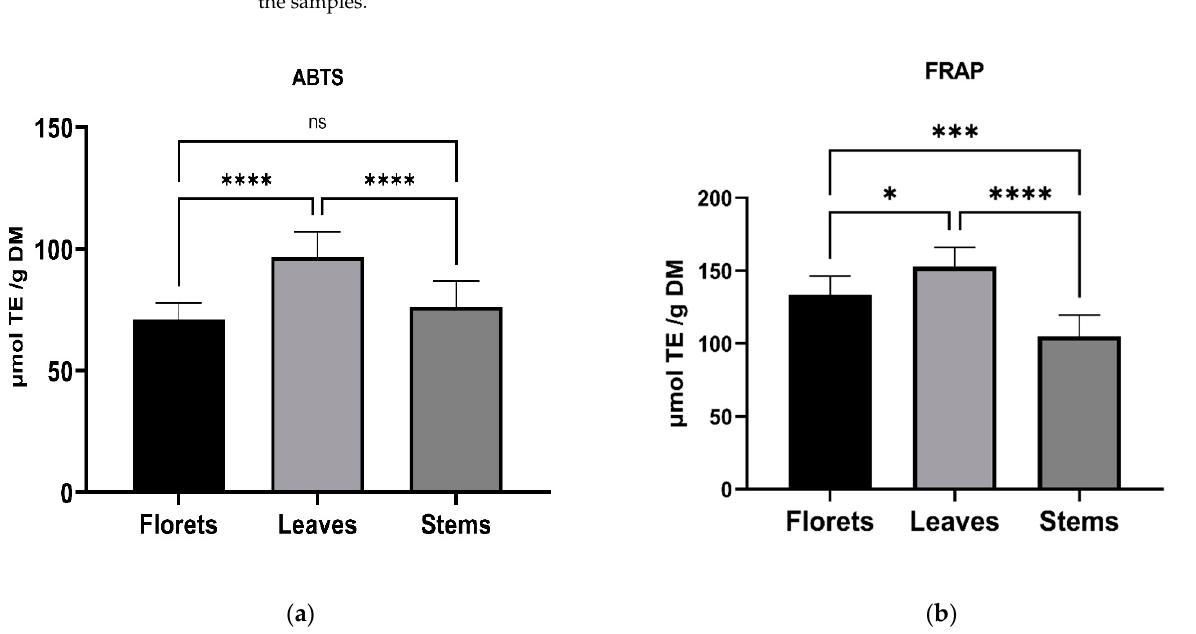
Figure 1. The antioxidant capacity of the aerial parts of cauliflower, expressed the mean ± SD ( n = 9) analyzed using ( a ) ABTS and ( b ) FRAP assays. ABTS—2,2 ′ -azino-bis (3-ethylbenzothiazoline-6-sulfonic acid) (ABTS)—radical cation-based assay; FRAP—ferric reducing antioxidant potential (FRAP) assay; TE—Trolox equivalents. (ns) – not significant; (*)— p -value < 0.05; (***)— p -value < 0.001; (****)— p -value < 0.0001.